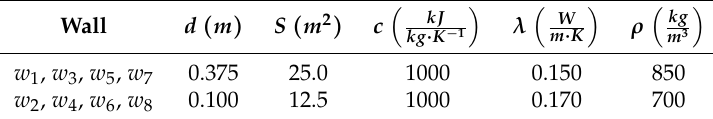
Table 5. The physical parameters of the particular